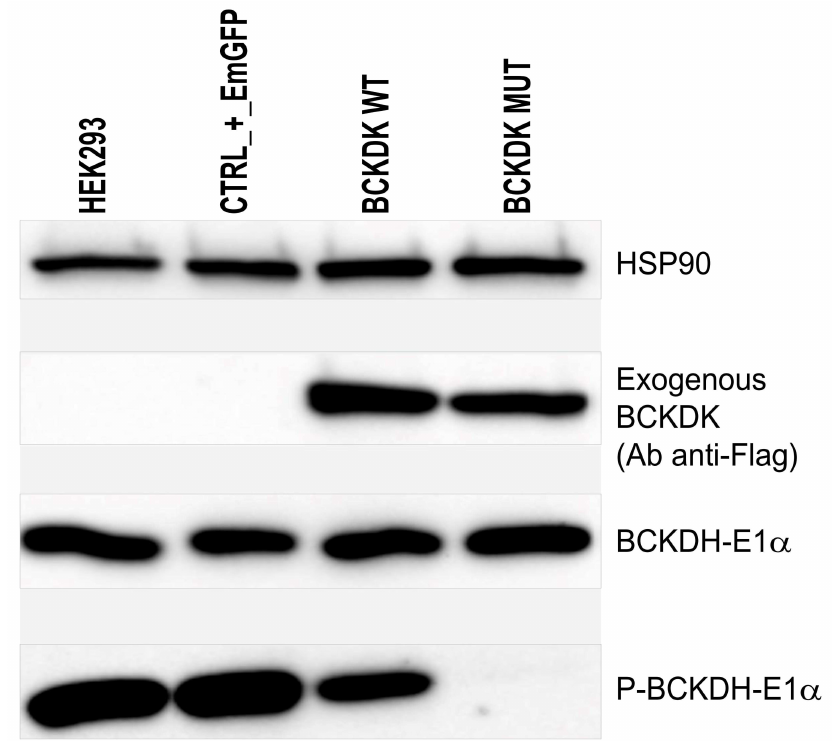
Figure 4. Western blot to detect exogenous BCKDK (Ab anti-Flag); E1 α subunit of BCKDH; phospho- rylated form of E1 α subunit of BCKDH, and HSP90 as charge control. From left to right: HEK-293 were left untreated, transduced with a transduction control (EmGFP), transduced with wild-type exogenous BCKDK, and transduced with mutated form of BCKDK